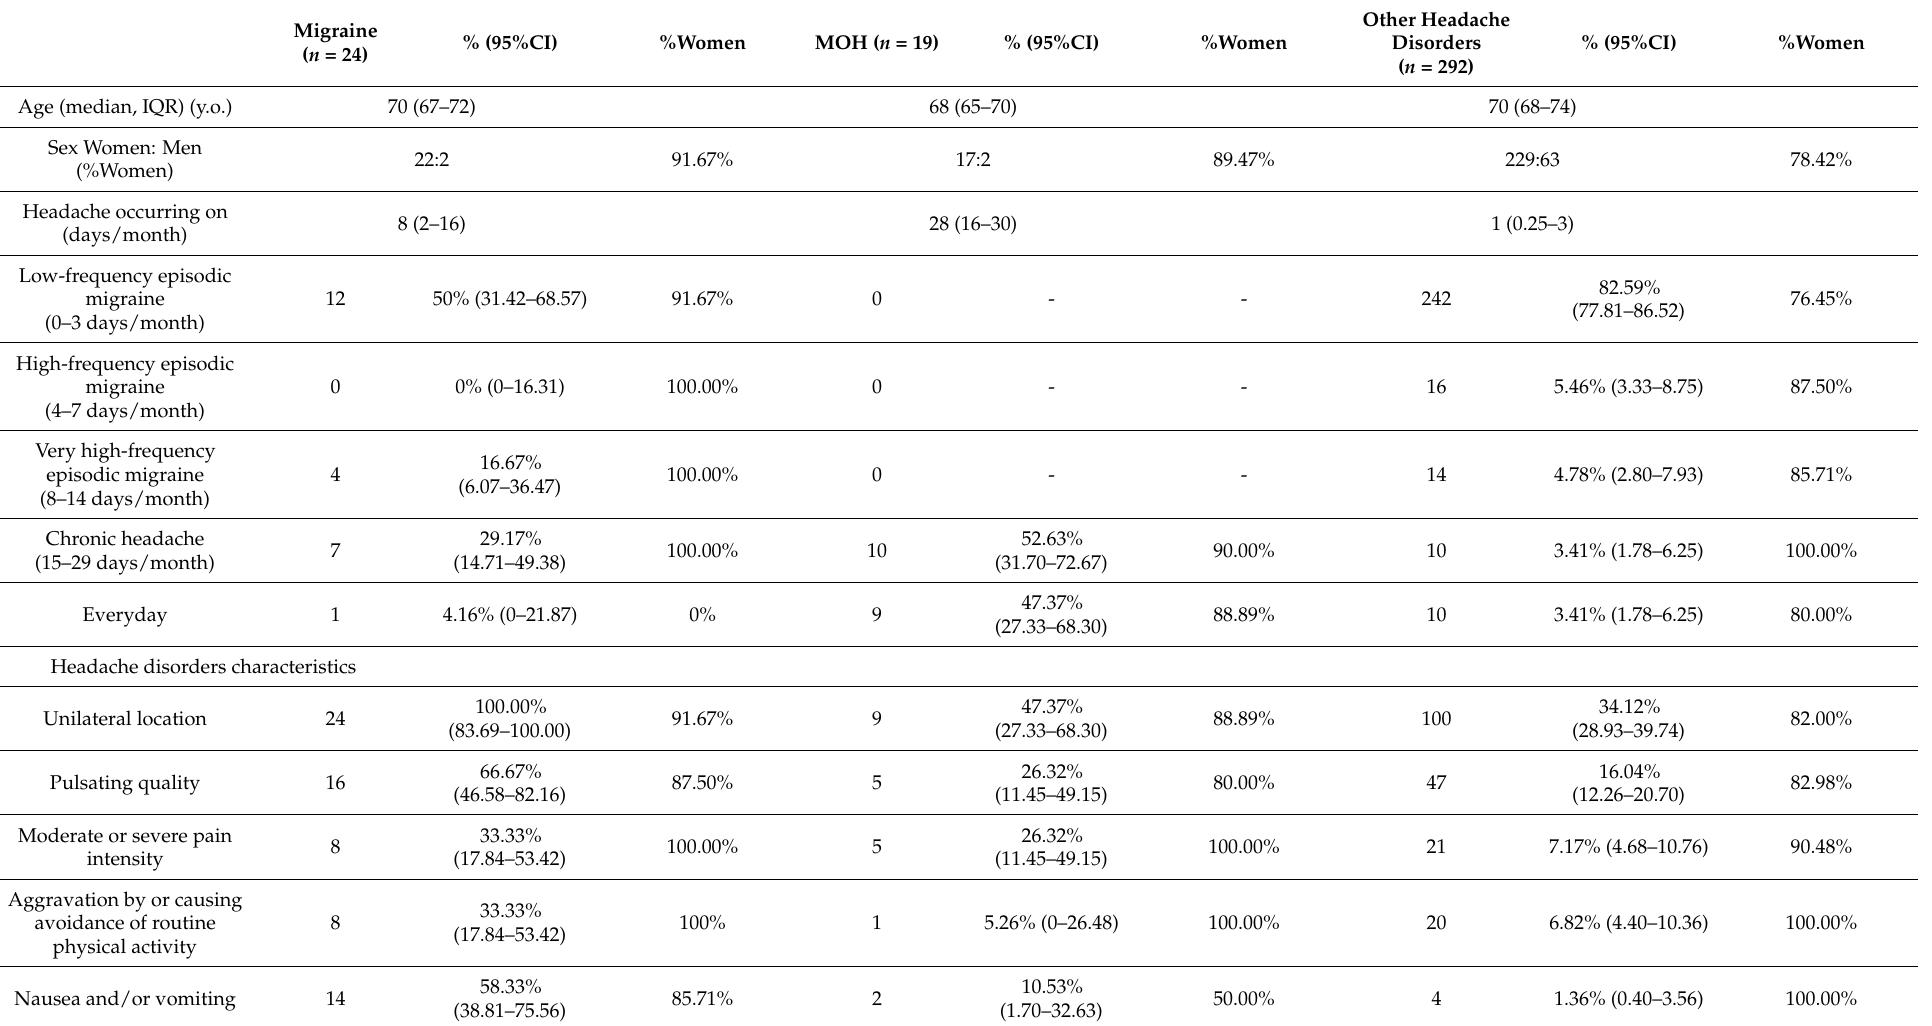
Table 3. Characteristics of migraine, MOH, and other headache disorders among the independent elderly with mRS